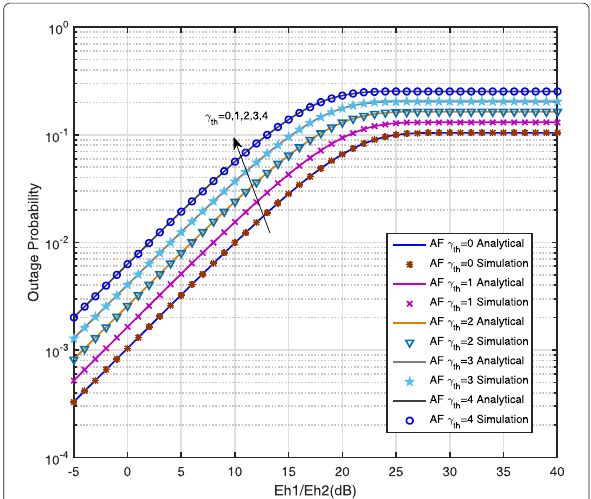
Fig. 7 Outage probability versus E h 1 for E h 2 = E h 3 with AF